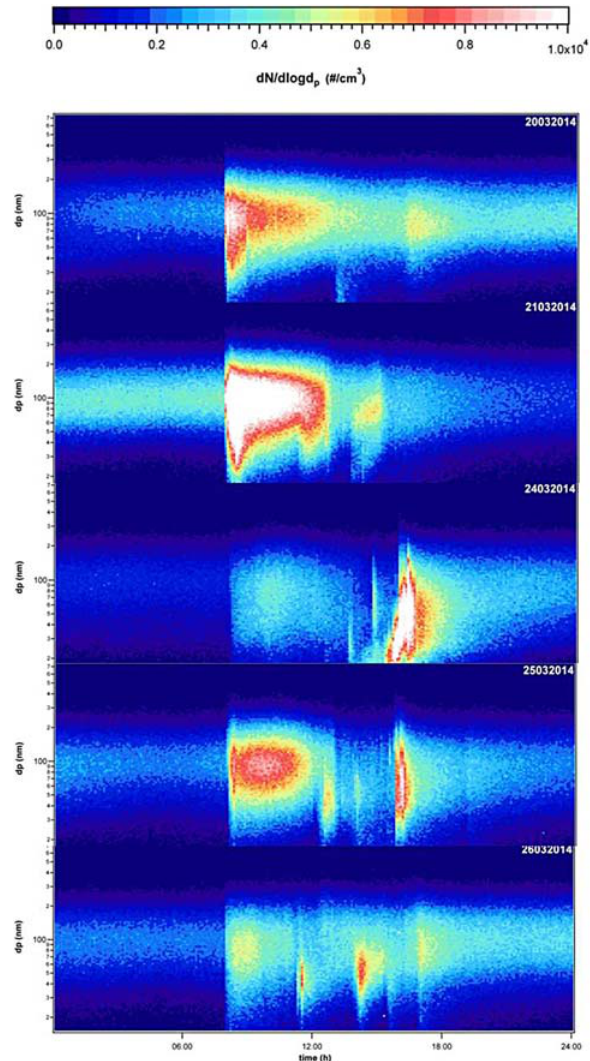
Figure 5: Number concentration (particle cm –3 ) and size distribu- tion of the particles continuously measured in Room 3 of the com- pany of spatial informatics and graphic design in Ljubljana, Slove- nia from March 20 to March 26, 2014. White color represents the concentrations above 10 × 10 3 particle cm –3